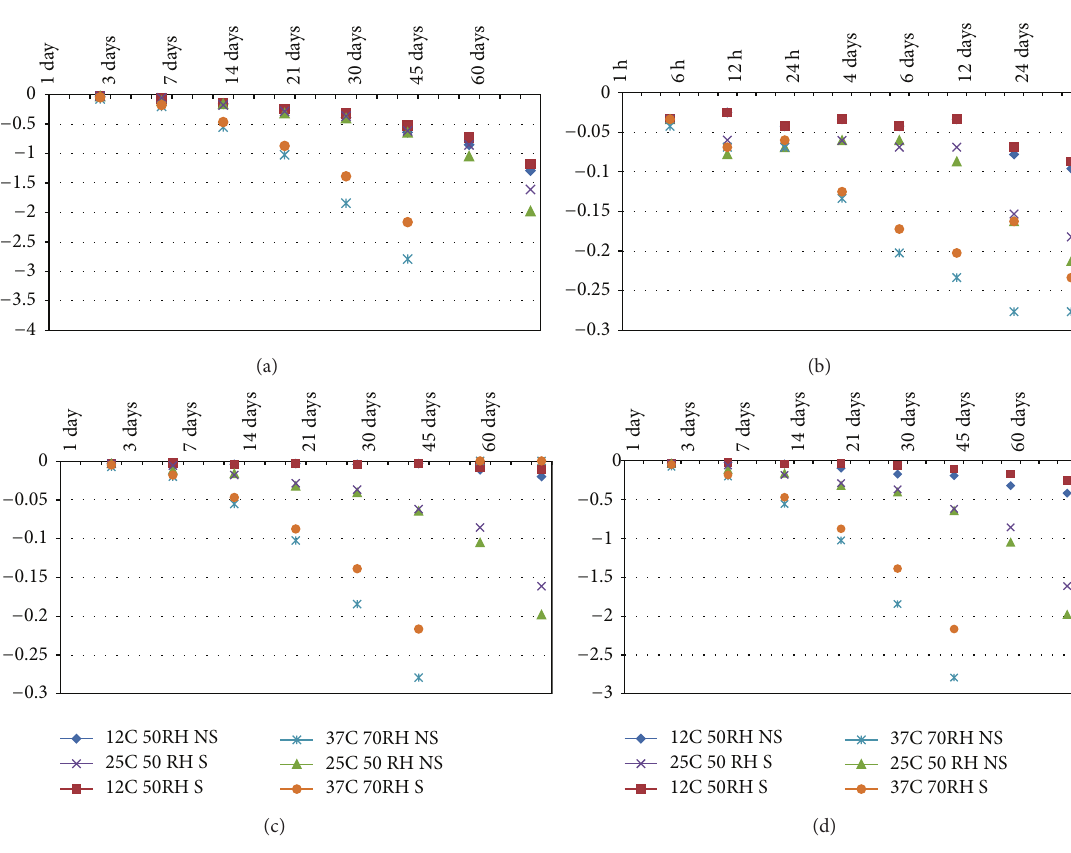
Figure 2: 𝐾 values for the first-order die-off rate of Cryptosporidium on (a) stainless steel, (b) skin, (c) formica, and (d)